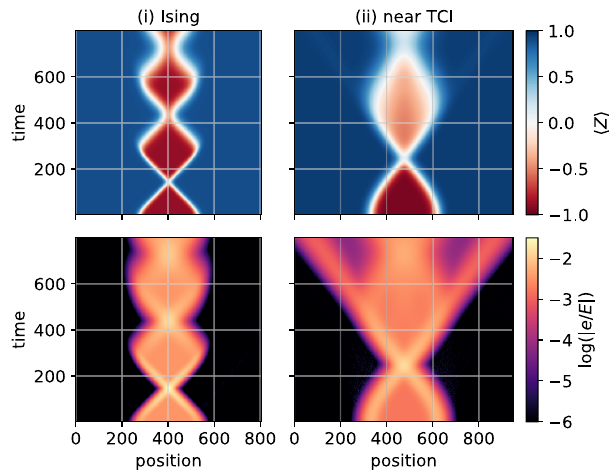
FIG. 7. Spin expectation values and relative energy density e / E for (i) the Ising model ( λ = 0, g = 0.8, h = 0.007, m μ ≈ 1.04, v max = 1.6, ξ ≈ 1.64) and (ii) the generalized Ising model nearer to the tricritical Ising CFT fixed point (TCI) ( λ = 0.41, g = 0.98, h = 0.001, m μ ≈ 0.43, v max ≈ 1.58, ξ ≈ 3.63).